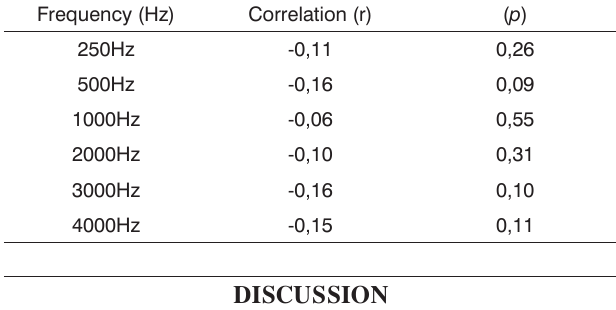
Figure 1. Comparison between true gain obtained from measurements with a microfone sonda and simulated gain in the hearing aid program- ming software at 250-4000 Hz Table 2. Correlation (Pearson) between the age of participants and the mean difference at different frequencies.